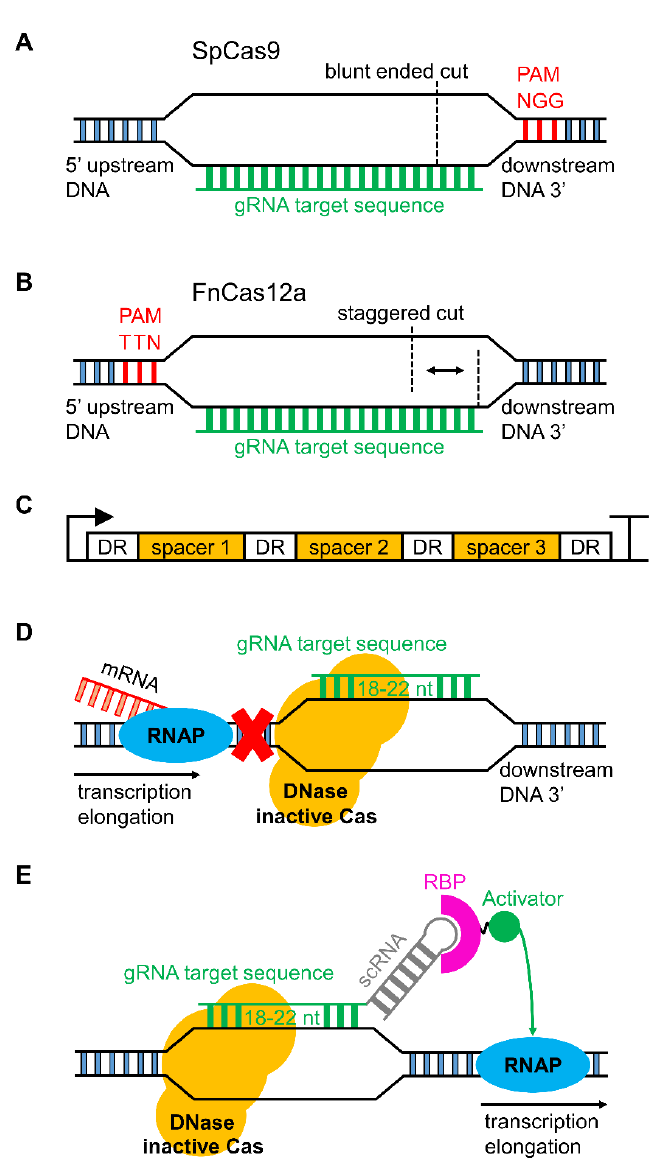
Figure 1. Basic overview of CRISPR / Cas-based genome editing and CRISPR interference in cyanobacteria. ( A ) The type II-A CRISPR / Cas system comprising SpCas9 that is targeted by a guide RNA (gRNA, green) upstream of an NGG protospacer adjacent motif (PAM) (red). SpCas9 generates a blunt-ended double-stranded break (DSB) in DNA (black dashed line). ( B ) The type II-V CRISPR/Cas system comprising FnCas12a that is targeted by a gRNA downstream of a TTN PAM. Cas12a confers a staggered DSB in DNA that results in a five-nucleotide overhang. ( C ) Illustration of a single expression cassette containing three spacers (i.e., a spacer array, orange) that are flanked by direct repeat regions (DRs, white). Cas12a recognises and cleaves spacers in response to a DR to generate a mature gRNA from each spacer. ( D ) Overview of transcriptional inhibition by CRISPRi. DNase inactive Cas enzymes (e.g., dCas9 or ddCas12a) are targeted to a DNA locus by a gRNA (typical length indicated as 18 – 22 nucleotides), which blocks RNA polymerase (RNAP, blue) to prevent mRNA (red) synthesis. ( E ) Example of transcriptional activation by CRISPRa. DNase inactive Cas enzymes (e.g., dCas9 or ddCas12a) are targeted by a gRNA fused to a scaffold RNA (scRNA, grey). The scRNA recruits an RNA binding protein (RBP, pink) fused to a transcriptional activator (green) (e.g., [108]), which subsequently leads to activation of RNAP and transcription elongation.